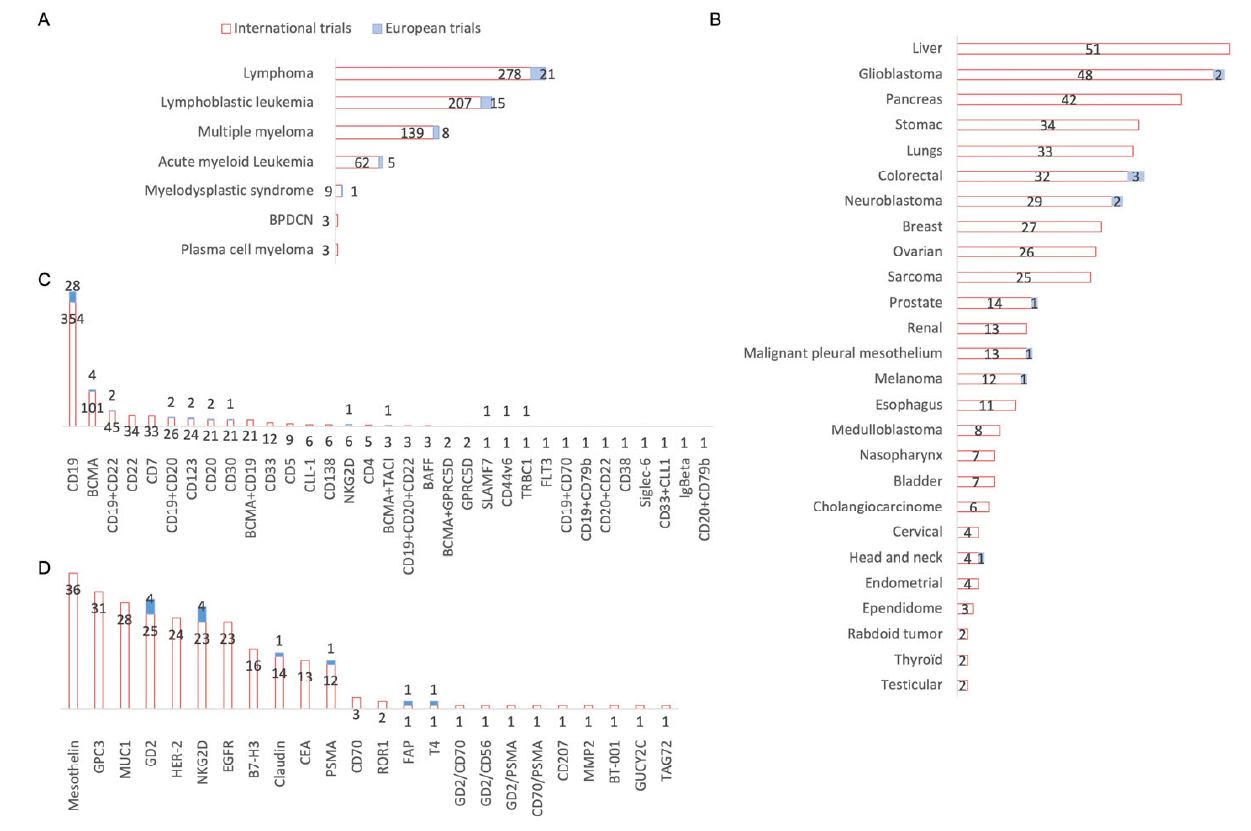
Figure 4. Conditions and targets studied in international and European CAR ‐ T cells clinical trials. ( A ) Focus on hematologic malignancies: 21 European studies focus on lymphomas all combined, 15 studies on lymphoblastic leukemia, 8 studies on multiple myeloma and 5 studies on acute myeloid. BPDCN: Blastic plasmacytoid dendritic cell neoplasm. ( B ) Focus on solid tumors: 3 European